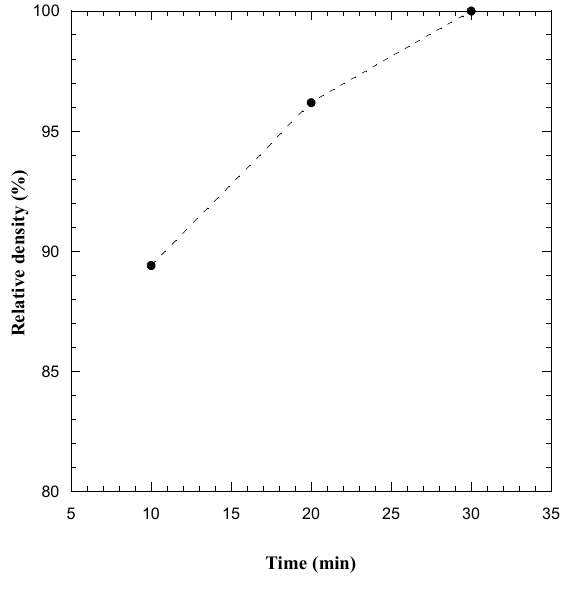
Figure 8. Influence of the sintering time on sample density during consolidation by SPS = 1800 °C, P = 20 MPa) of HfB ( T D